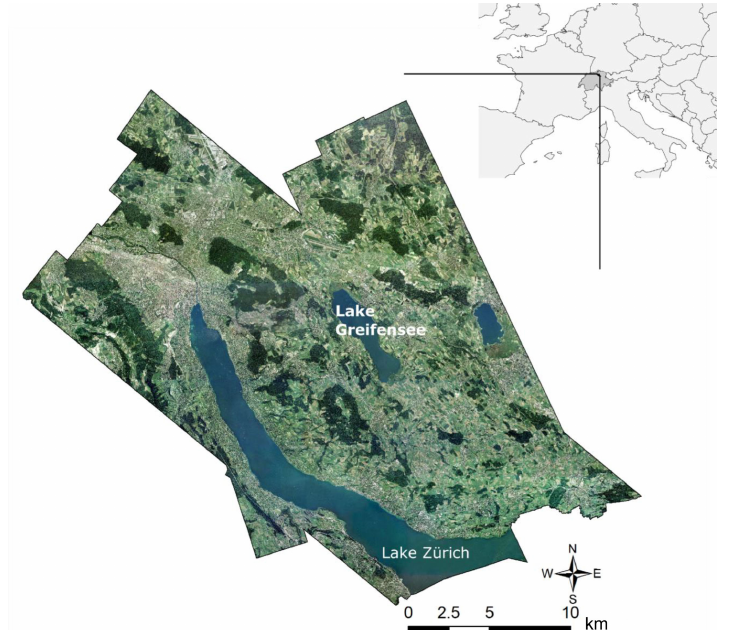
Figure 1. Study area in the Swiss Plateau, 672489–715769 X , 228156–259960 Y , GCS_CH1903 (orthophoto study area: SWISSIMAGE 2005, ©swisstopo. Administrative boundaries Europe: NUTS 2010,